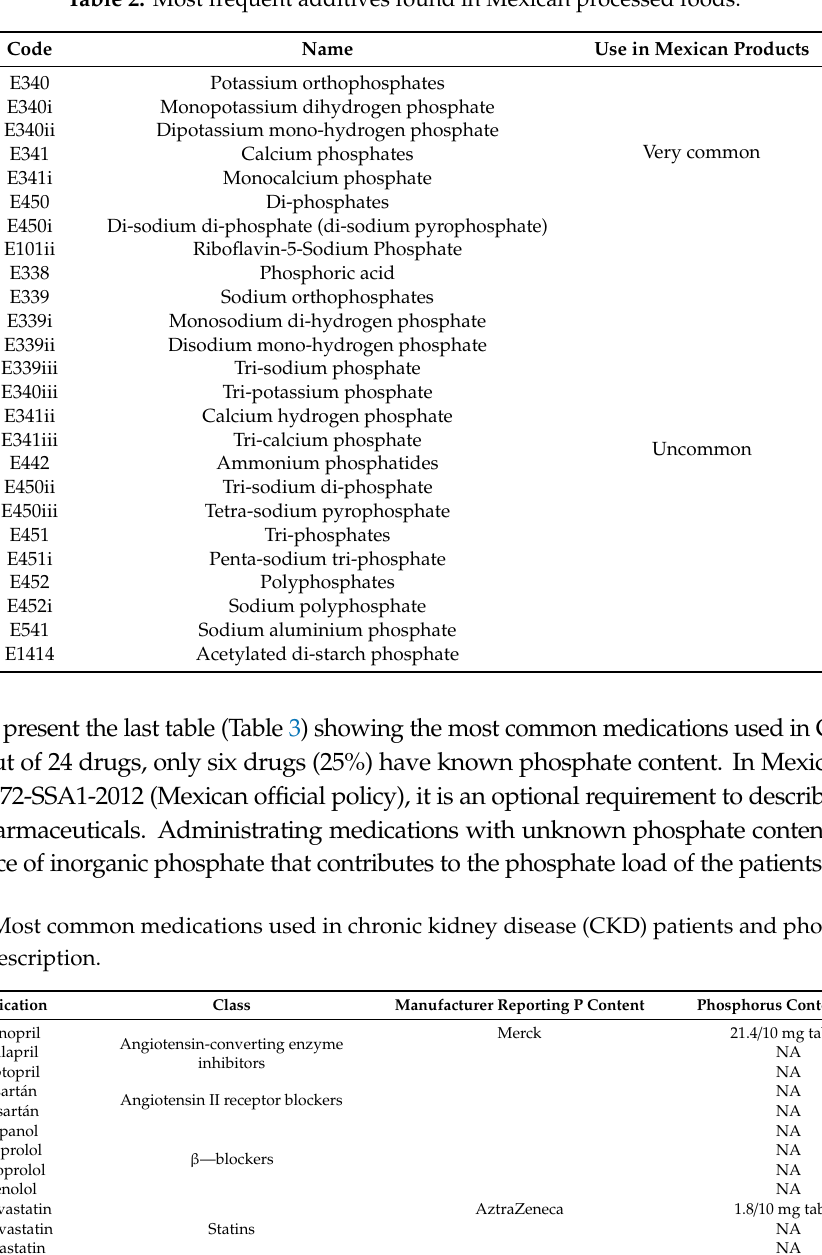
Table 2. Most frequent additives found in Mexican processed foods.